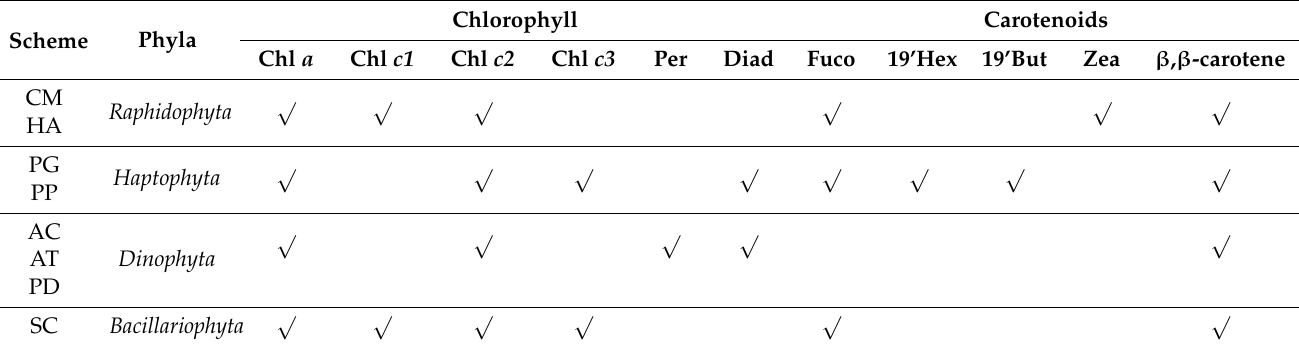
Table 1. Composition of pigments in different species of algae.